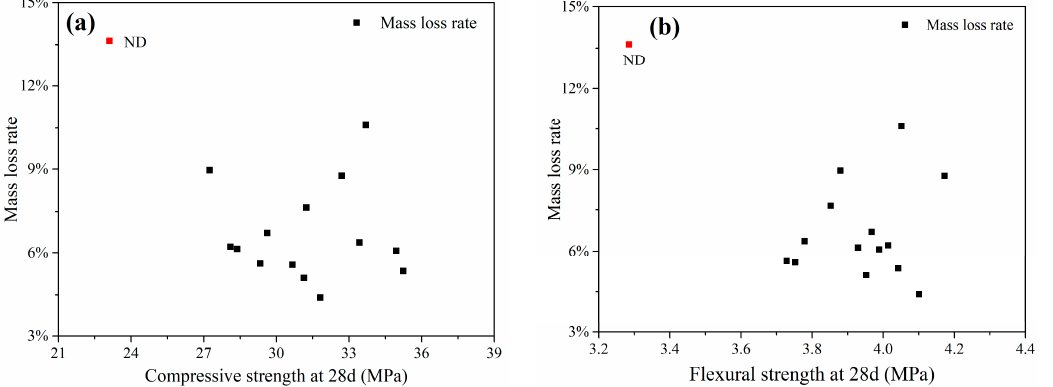
Figure 14. Relationship between mass loss rate and strength: ( a ) compressive strength, ( b ) flexural strength.